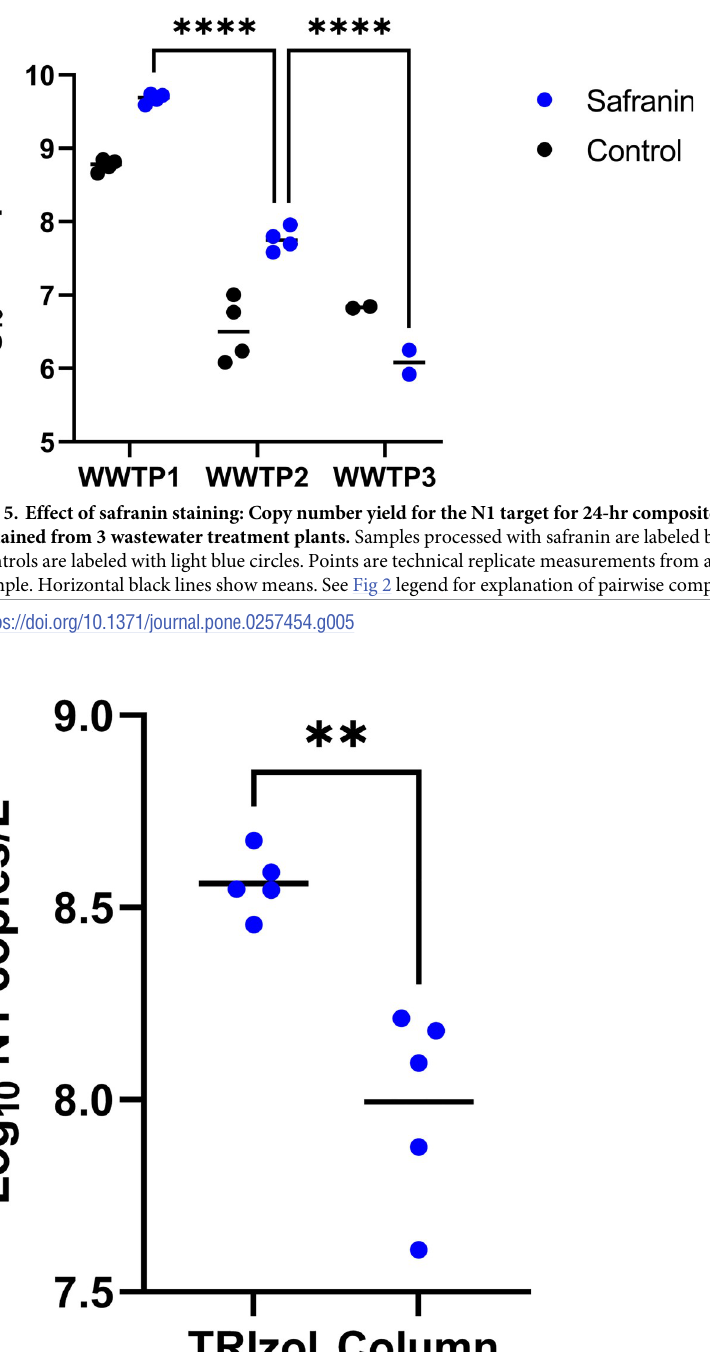
PLOS ONE | https://doi.org/10.1371/journal.pone.0257454 September 23,